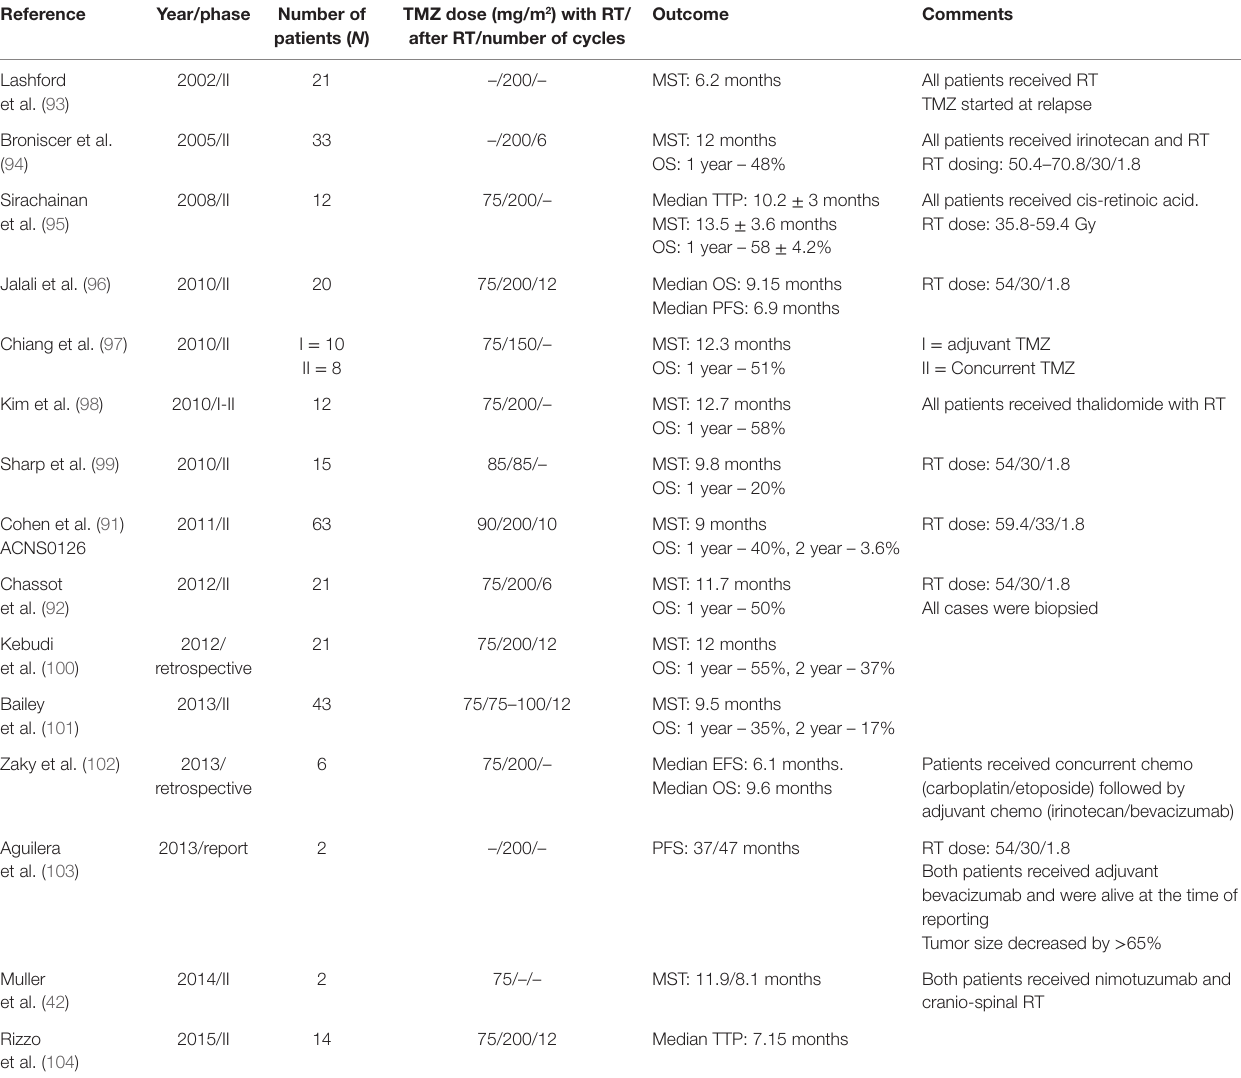
TABLe 4 | Concomitant and Adjuvant Temozolomide (TMZ) based chemotherapy in DiPG.